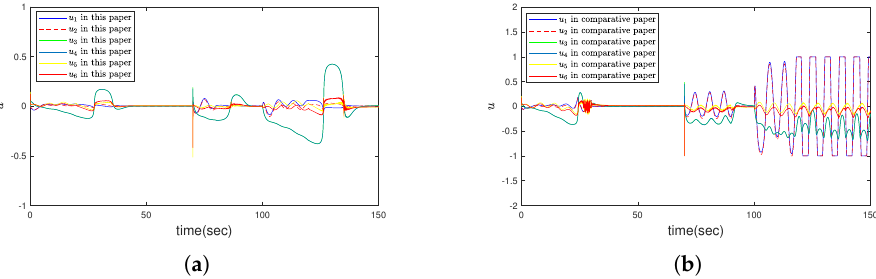
Figure 7. ( a ) The response curves for control law u ( t ) in this paper. ( b ) The contrastive curves for control law u ( t ) in method that ignores the effect of thruster saturation in